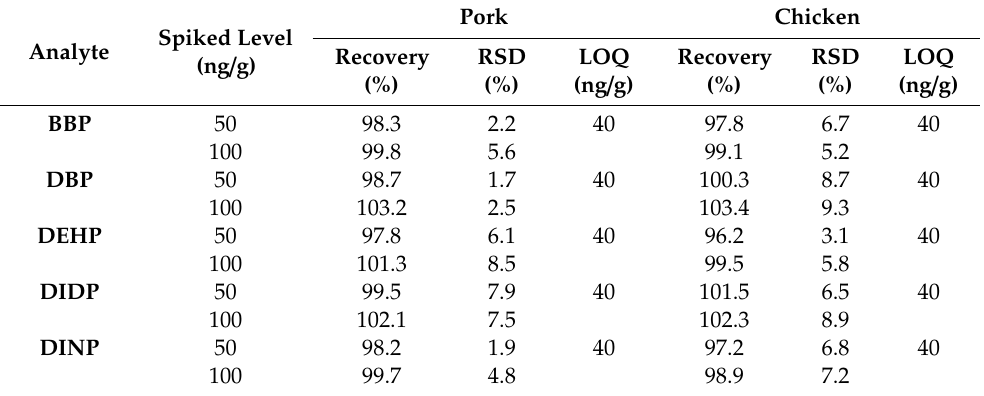
Table 1. Recovery, repeatability, and limit of quantification (LOQ) results for spiked phthalate levels in pork and chicken.